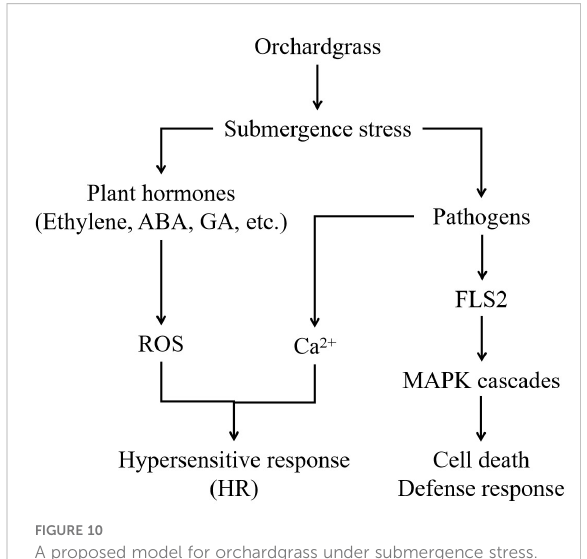
FIGURE 10 A proposed model for orchardgrass under submergence stress. The fi gure depicts the interplay and crosstalk of plant hormones, pathogen interaction, and MAPK cascades in orchardgrass during submergence